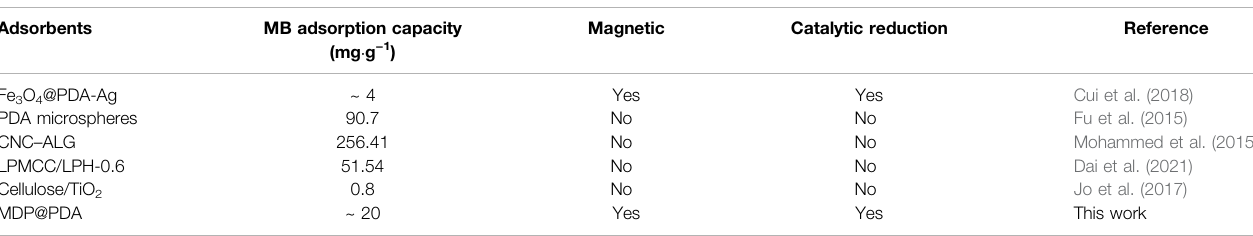
TABLE 1 | Comparison of the comprehensive properties of absorbents for MB adsorption.